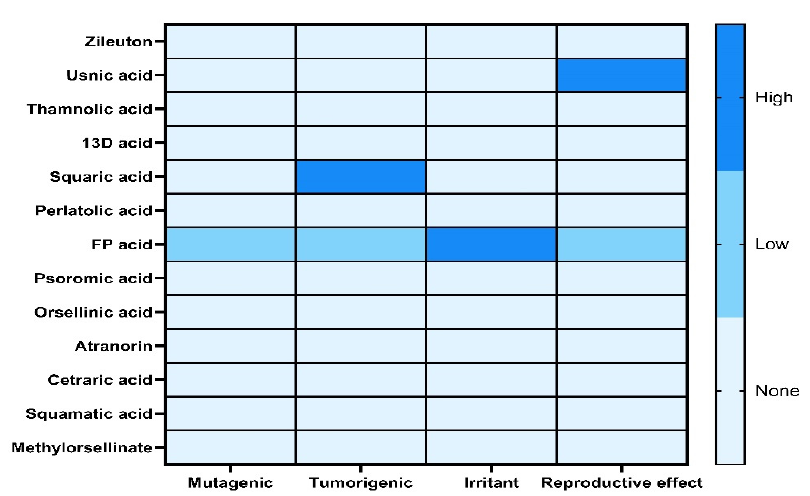
Figure 3. The heat map representation of the toxicity risk of compounds present in the species of the genus Cladonia compared to the 5-LOX redox inhibitor (Zileuton) was realized with GraphPad Prism v.7 (GraphPad; La Jolla, CA, USA).